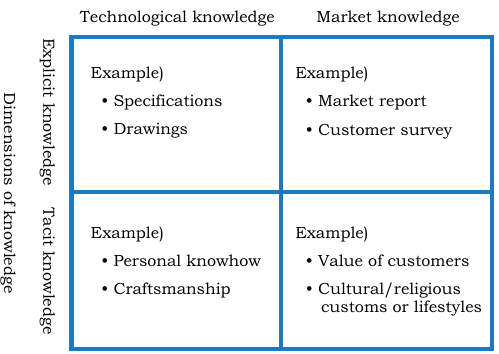
Figure 1. Required types of knowledge for product